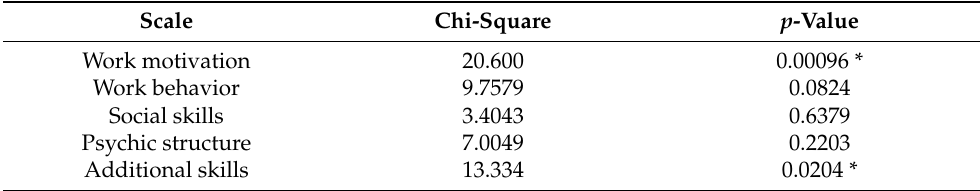
Table 17. Kruskal–Wallis test statistics when the sample is differentiated by years of teaching experience.